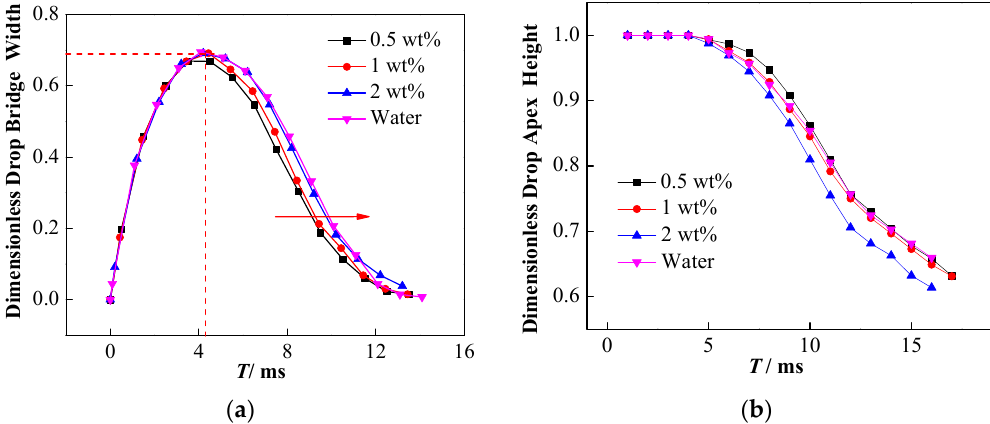
Figure 11. Effect of NPs on droplet bridge topological changes. ( a ) Effect of NP concentration on the development of dimensionless liquid bridge width; ( b ) effect of NP concentration on dimensionless droplet apex height.